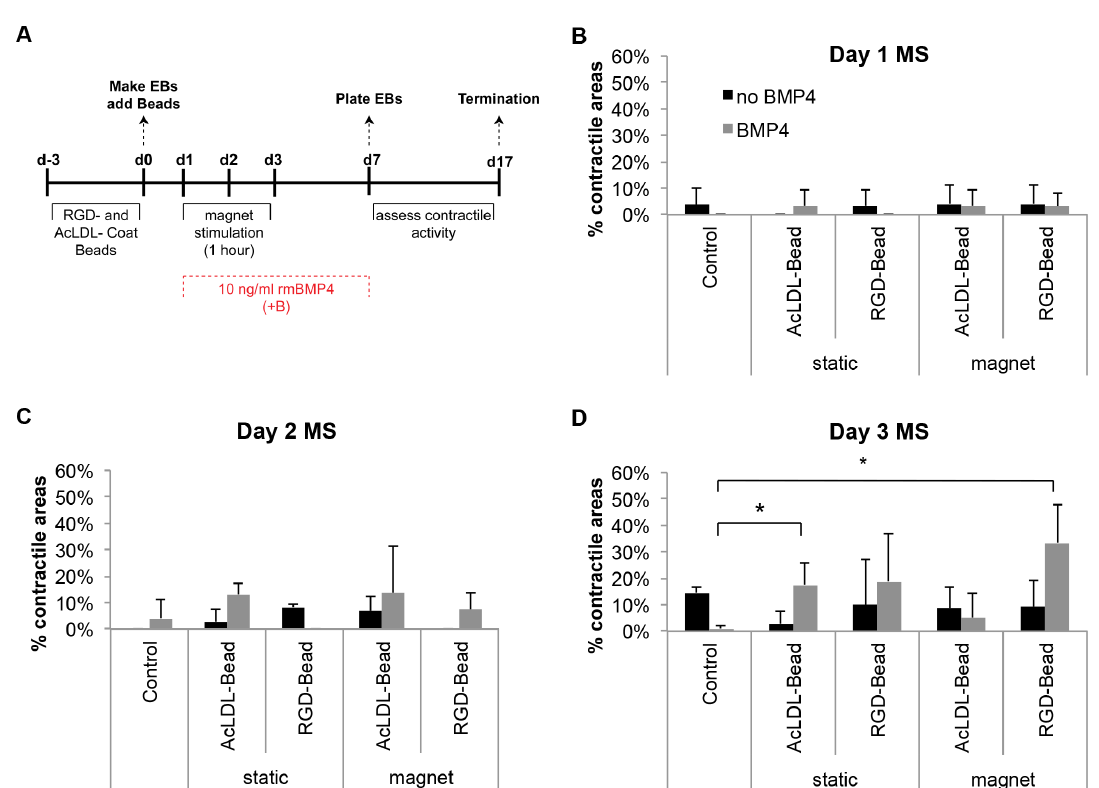
Fig. 6. Percentage of EBs with contractile areas on Day 17. (A) Timeline of EB mechanical stimulation and culture. BMP4 (10 ng/ml) was added between Days 1–7. EBs were stimulated on Day 1 (B), Day 2 (C), or Day 3 (D) in the presence or absence of BMP4. MS: mechanical stimulation. * p ,